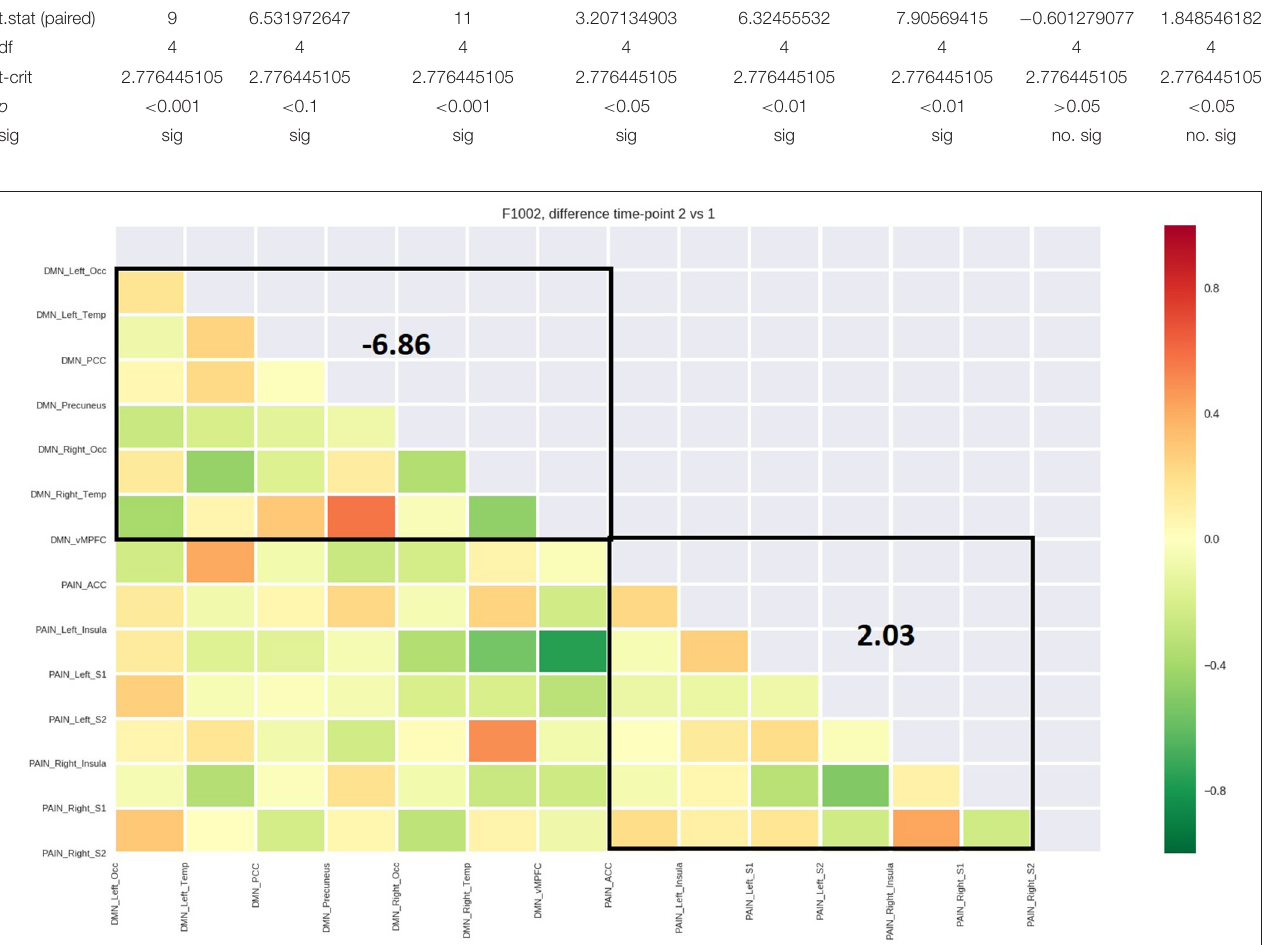
FIGURE 2 | Matrix difference T2–T1 of the first patient and DMN and PN average connectivity.